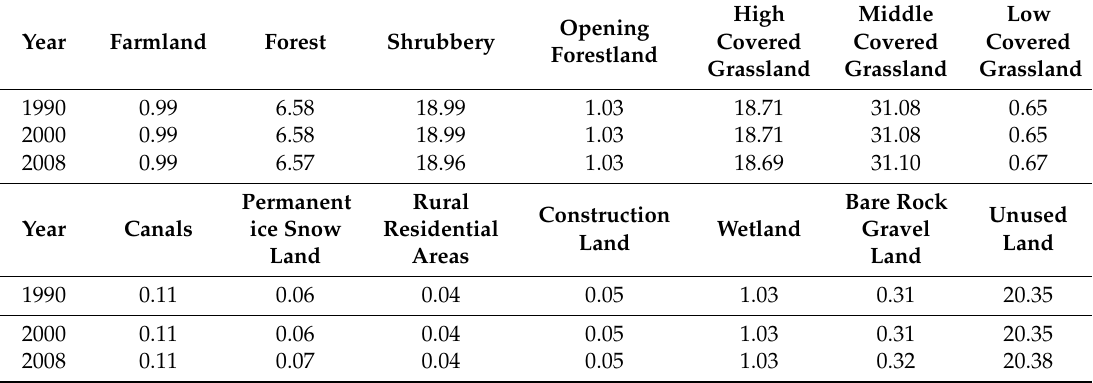
Table 1. Land use classification (%) of the Xiying River basin in 1990, 2000, and 2008. Year Farmland Forest Shrubbery